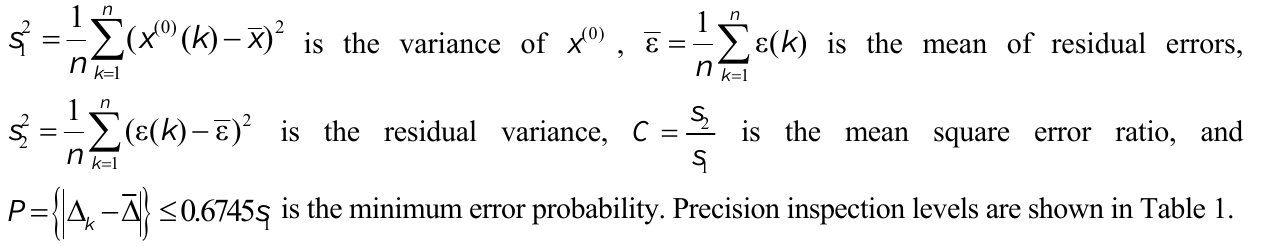
Table 1. Reference values for precision inspection levels. Index C P Excellent ≤ 0.35 ≥ 95% Well ≤ 0.50 ≥ 80% Accuracy grade Conformity ≤ 0.65